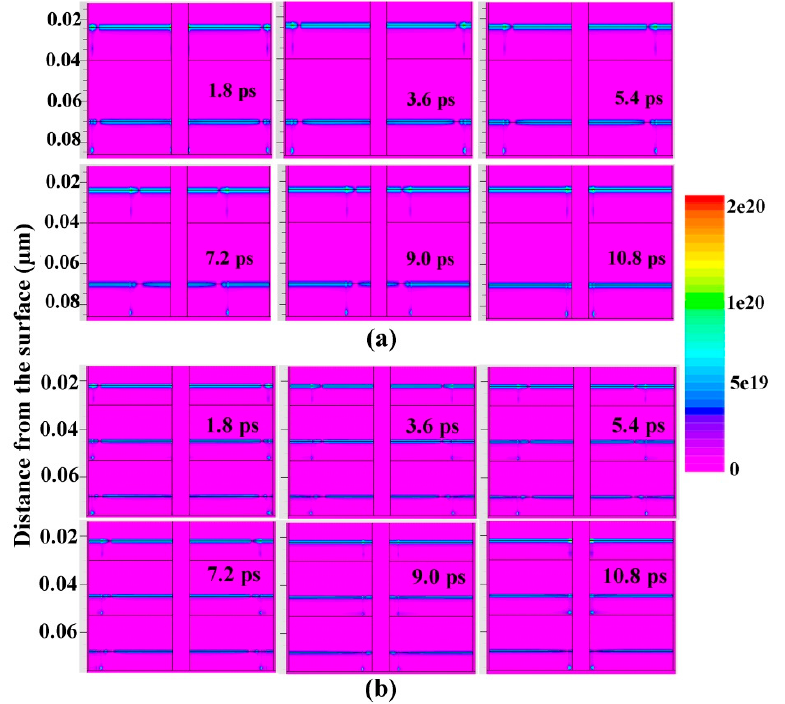
Figure 3. The schematic of the formation process of the electron domain in the 1.0 µm-self-parallel planar Gunn diode with ( a ) two 2DEG channels and ( b ) three 2DEG channels.